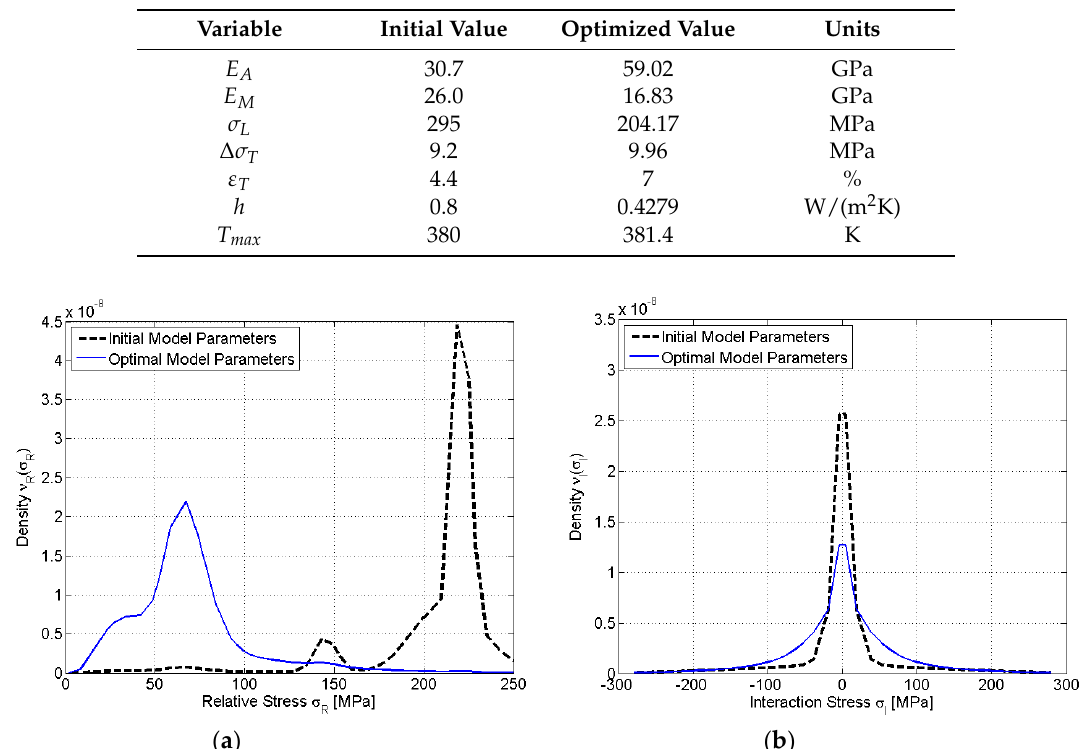
Table 2. Comparison of initial and optimized homogenized energy model (HEM) parameters.